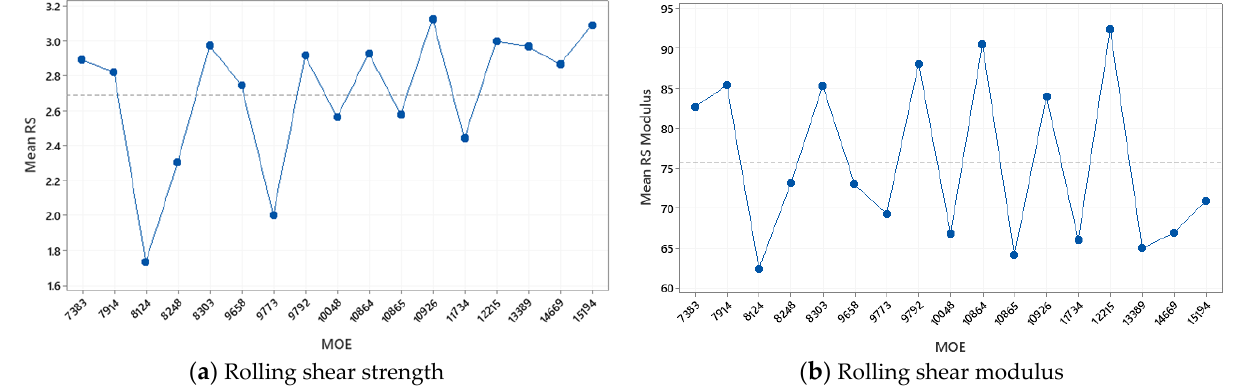
Figure 9. Rolling shear properties for various MOE (radiata pine).